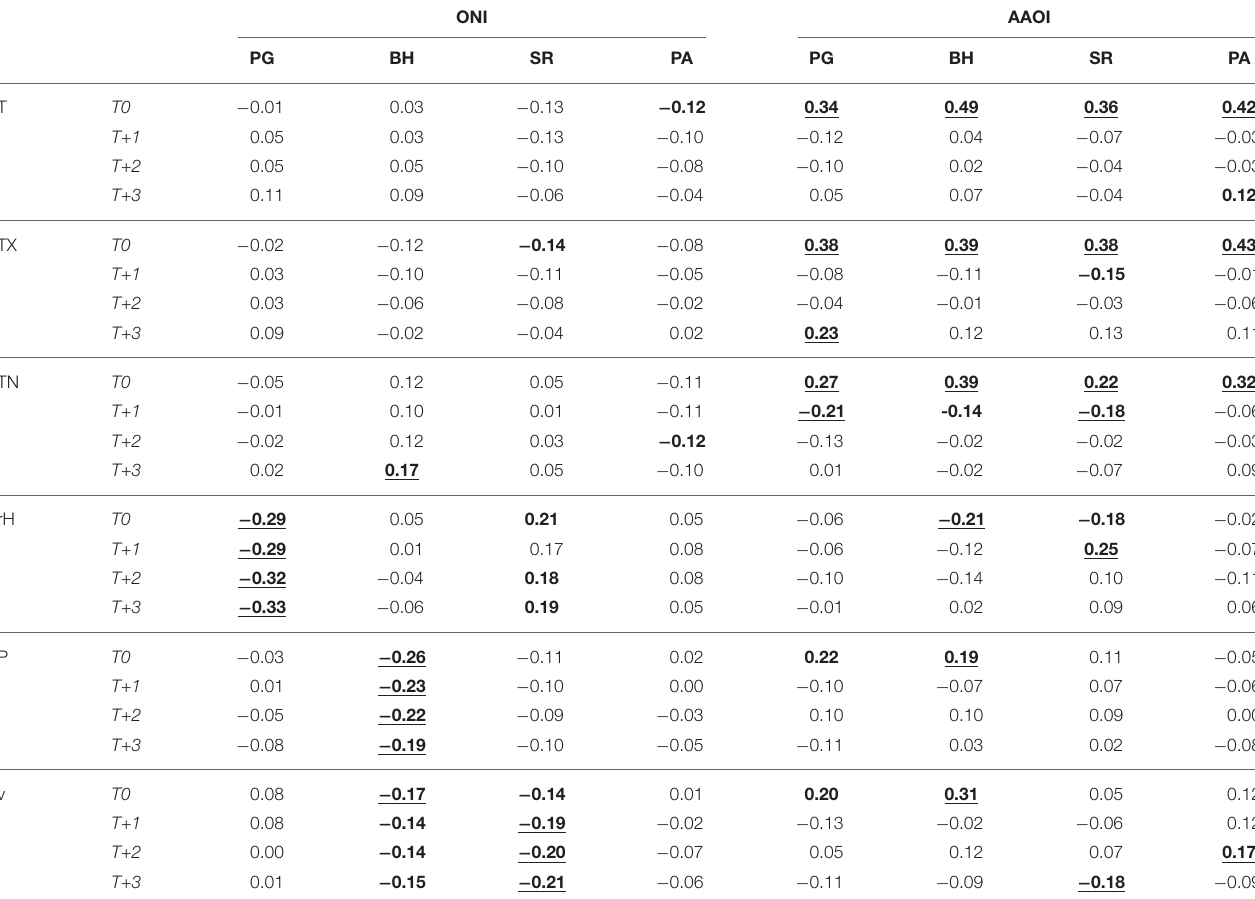
TABLE 7 | Correlation between ONI and AAOI and monthly anomalies of mean (T), maximum (TX), and minimum (TN) air temperature, relative humidity (rH), precipitation (P) and wind speed (v) at AWS Paso Galería (PG), AWS Puerto Bahamondes (BH), AWS Skyring (SR), and WS Punta Arenas (PA) for different time lags (T0 to T + 3 months). ONI AAOI PG BH